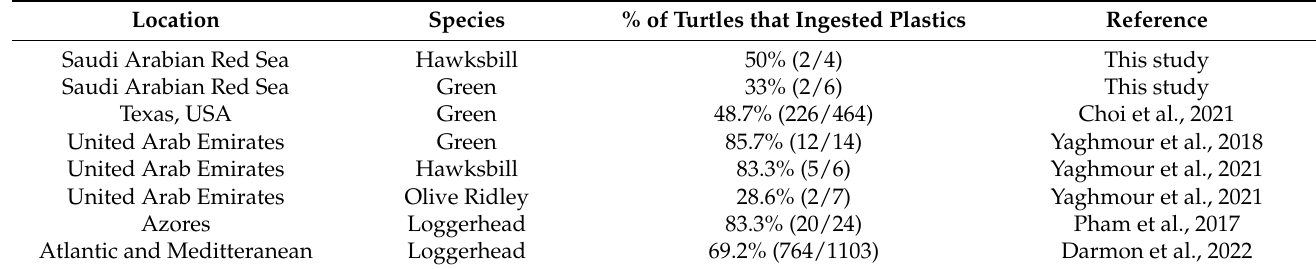
Table 2. Comparison of plastic ingestion found in this study with some findings from the